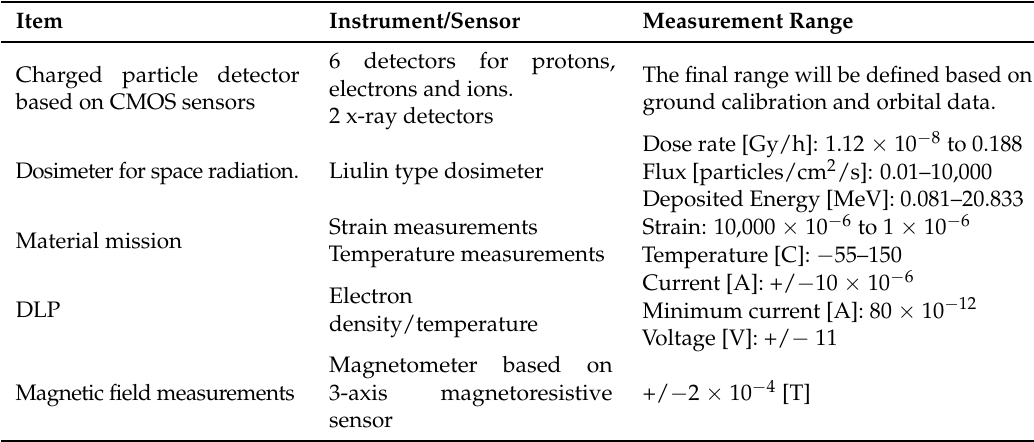
Table 1. Main payload